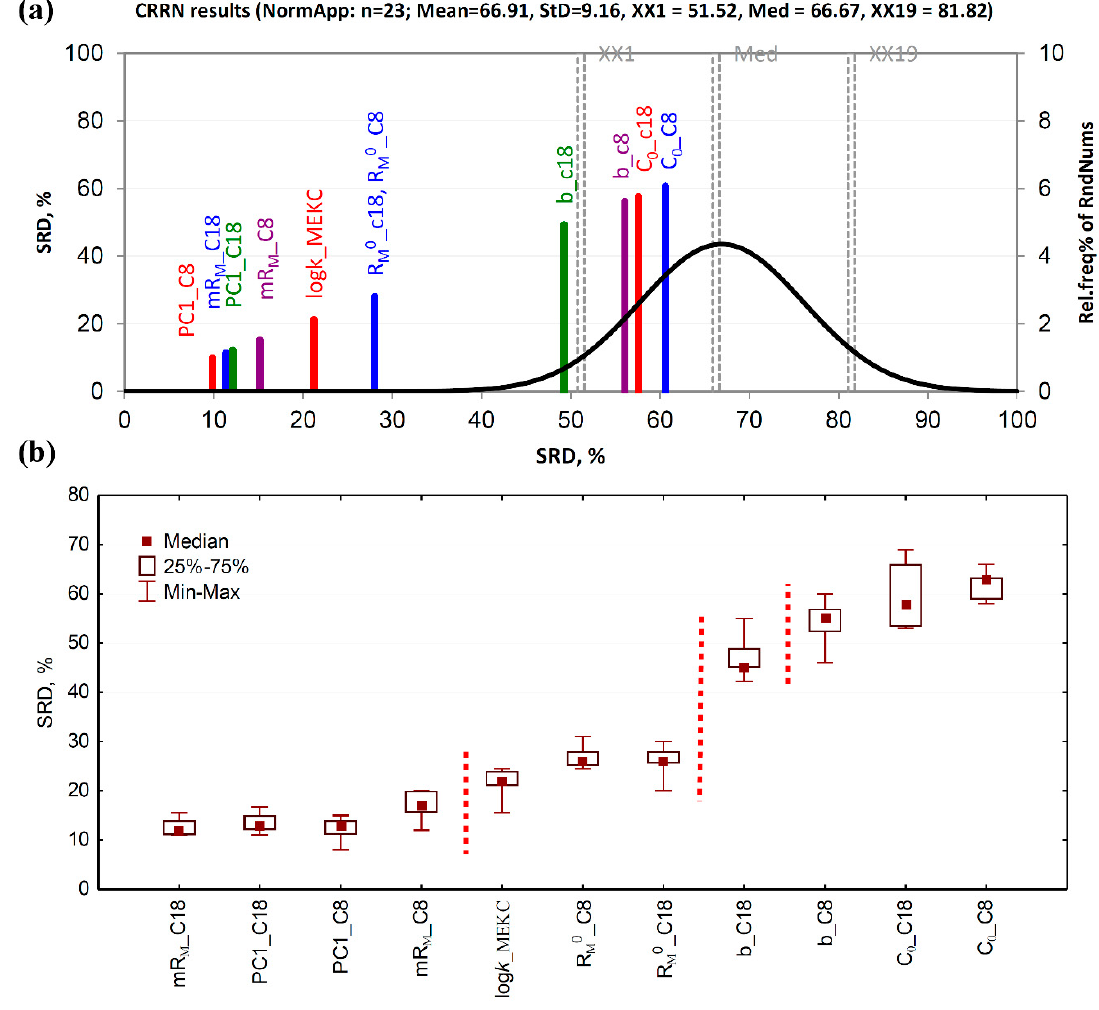
Figure 3. Consensus-based ranking of chromatographic lipophilicity indexes. ( a ) SRD-CRRN of standardized lipophilicity measures; the SRD values are depicted on x and y axes, n = 23, random distribution Mean = 66.91, StD = 9.16, XX1 = 51.52, Med = 66.67, XX19 = 81.82. ( b ) Box and whisker plot of normalized SRD values obtained by the sevenfold cross-validation. Indexes for which the median SRD values are statistically significantly different at the predefined significance level of p = 0.05 (tested by both the sign test and the Wilcoxon’s matched pairs test) are separated by dashed lines.